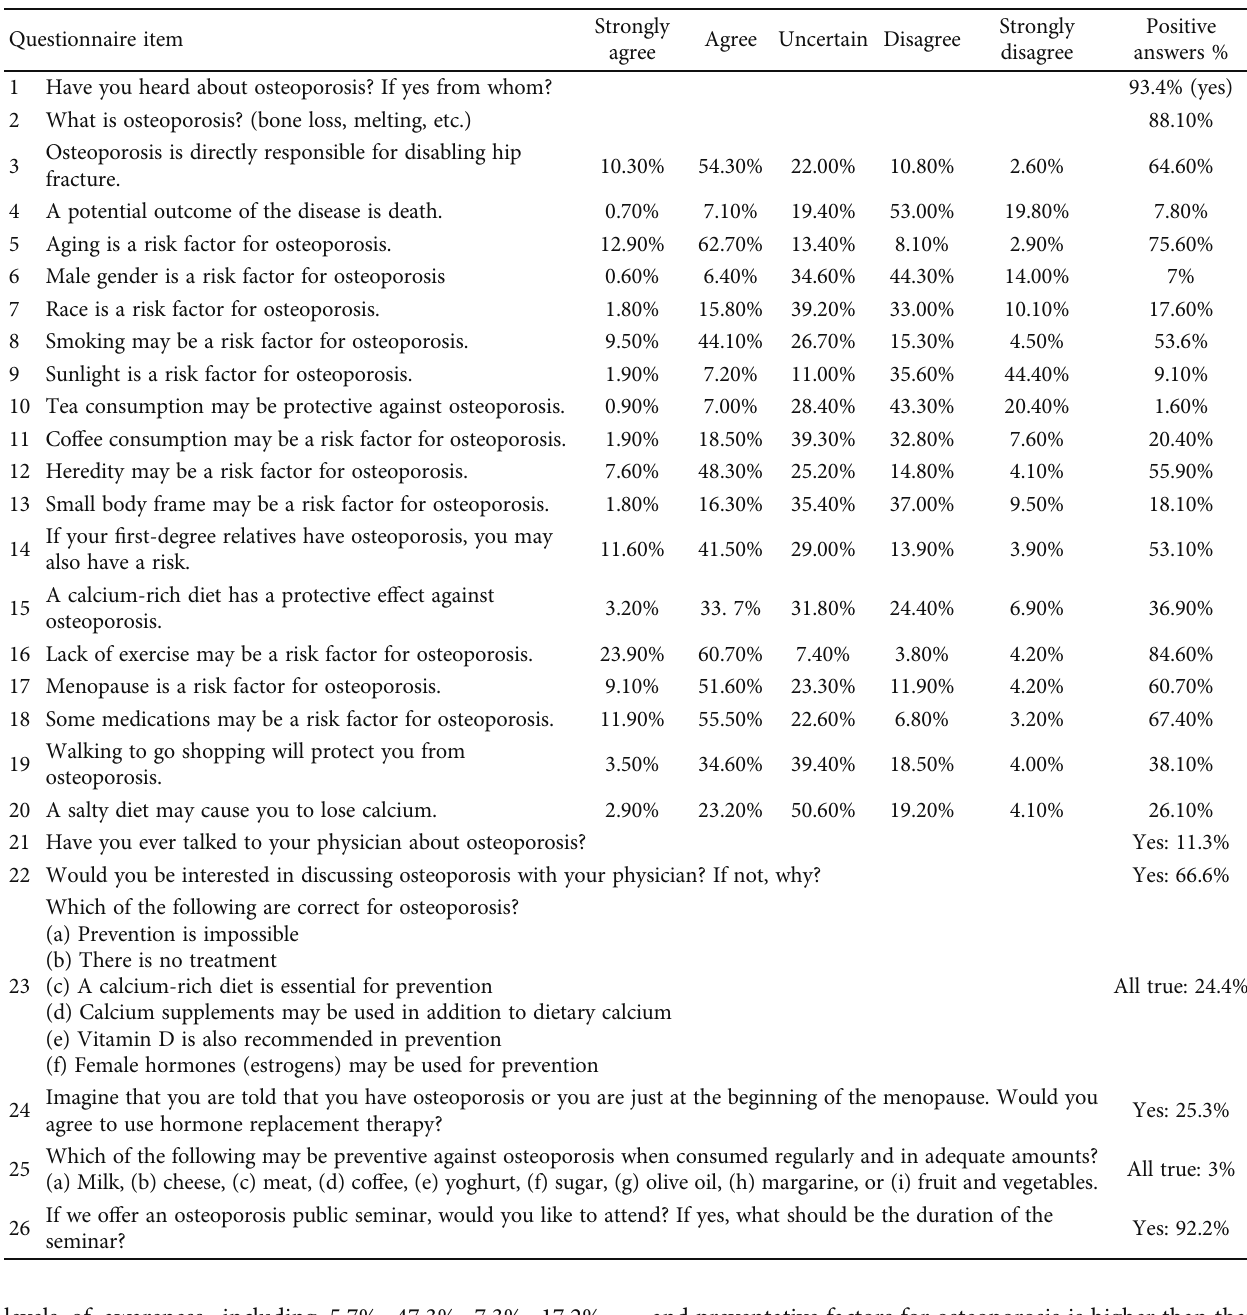
Table 2: Descriptive table of the questionnaire used to assess knowledge on osteoporosis among Syrian women. Questionnaire item